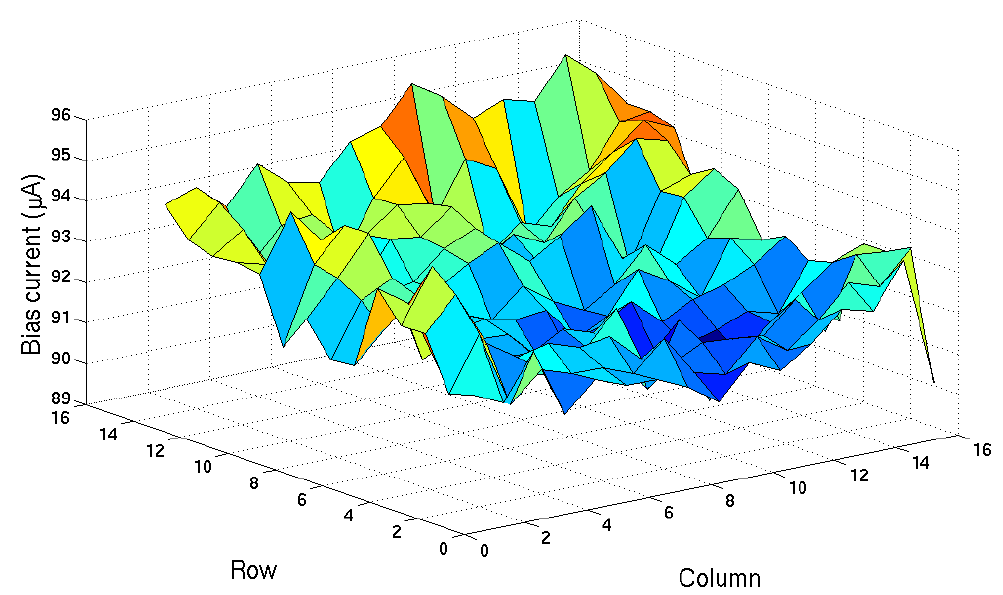
Figure 9. Bias current values to set the output DC level of each individual input channel to 1.5 V across the entire